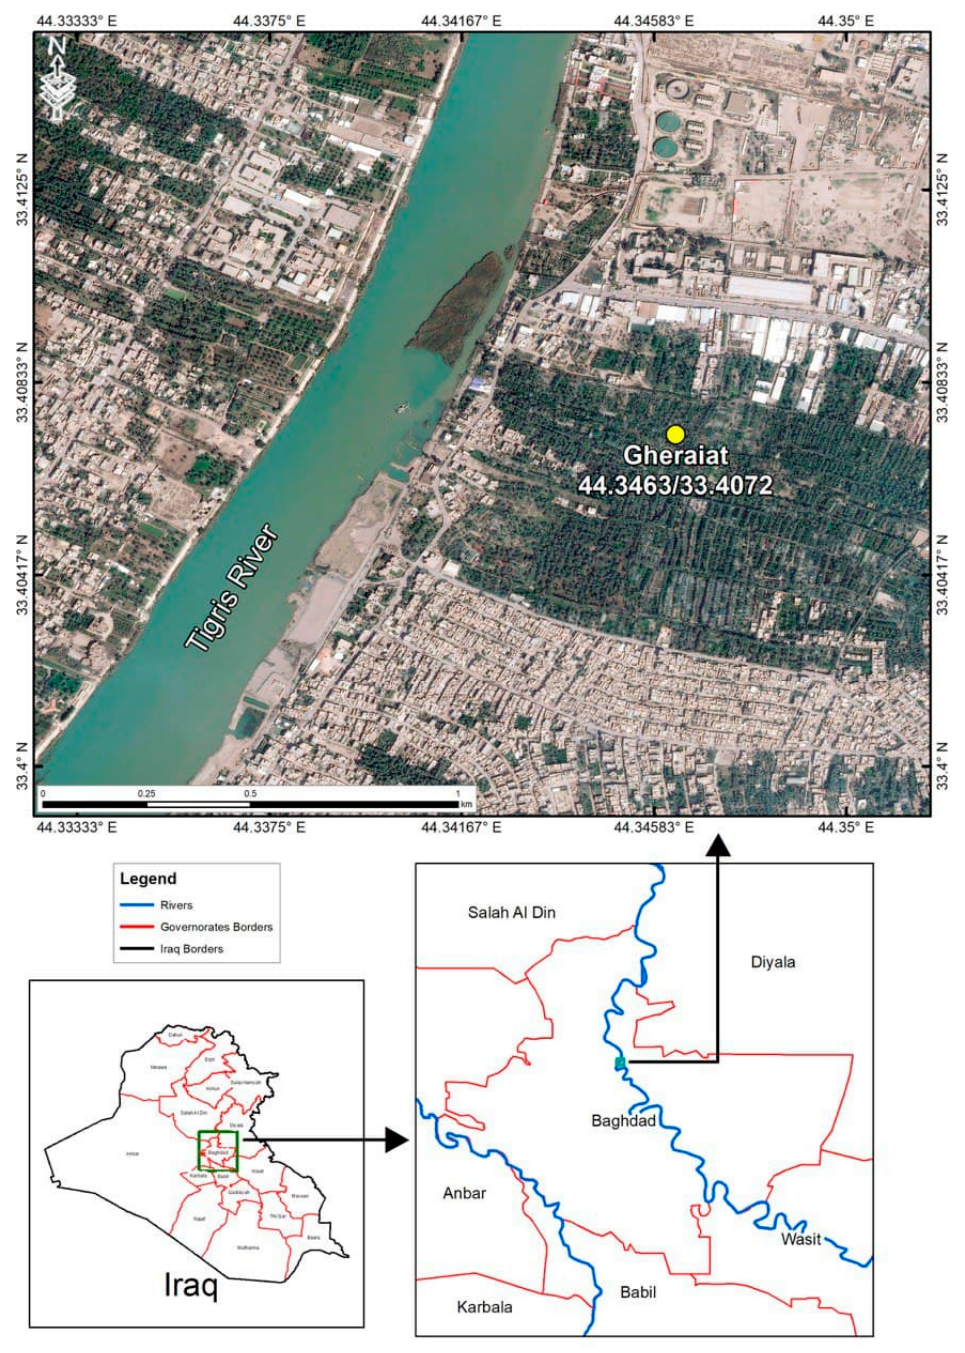
Figure 1. Location of the research area in this study, Baghdad City, Iraq.